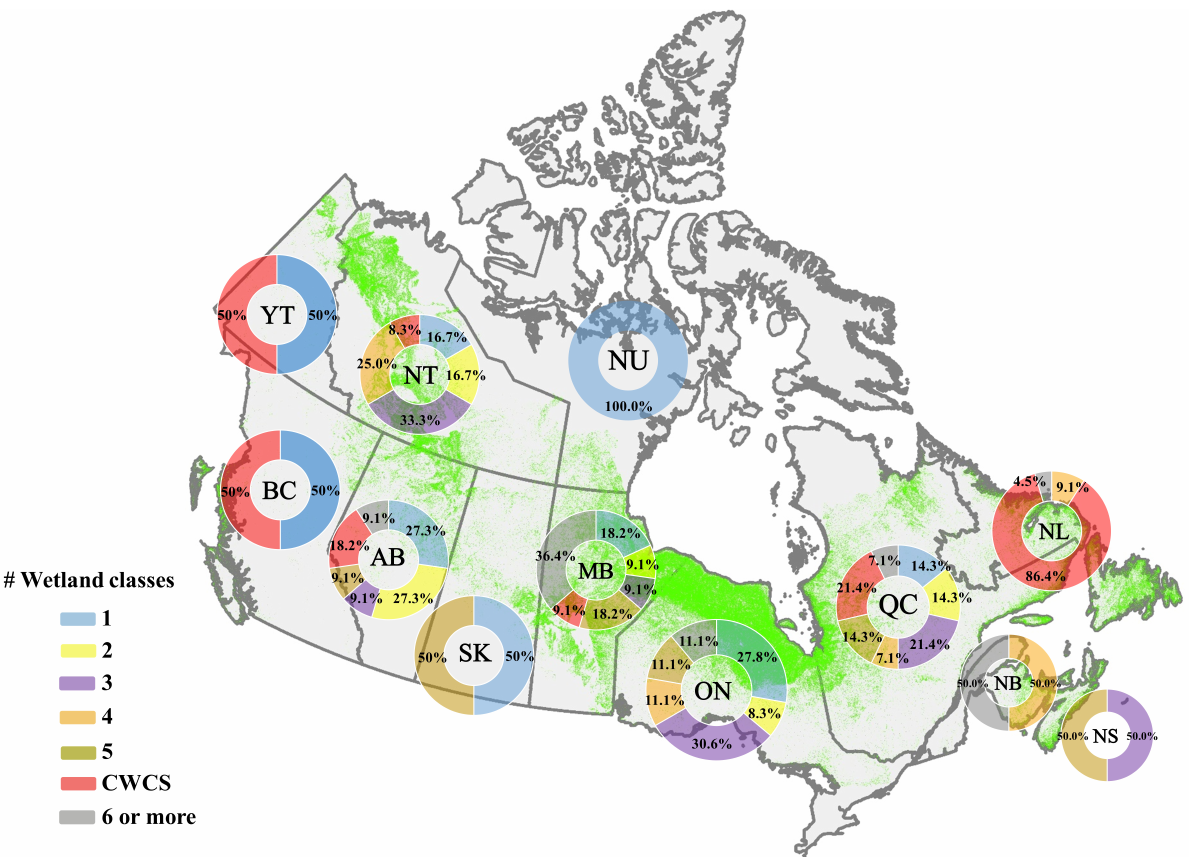
Figure 9. The province-based analysis of the number of wetland classes included in the published papers with the Canada wetland layer (Canada post-2000 wetland extent [90,91]) superimposed onto the